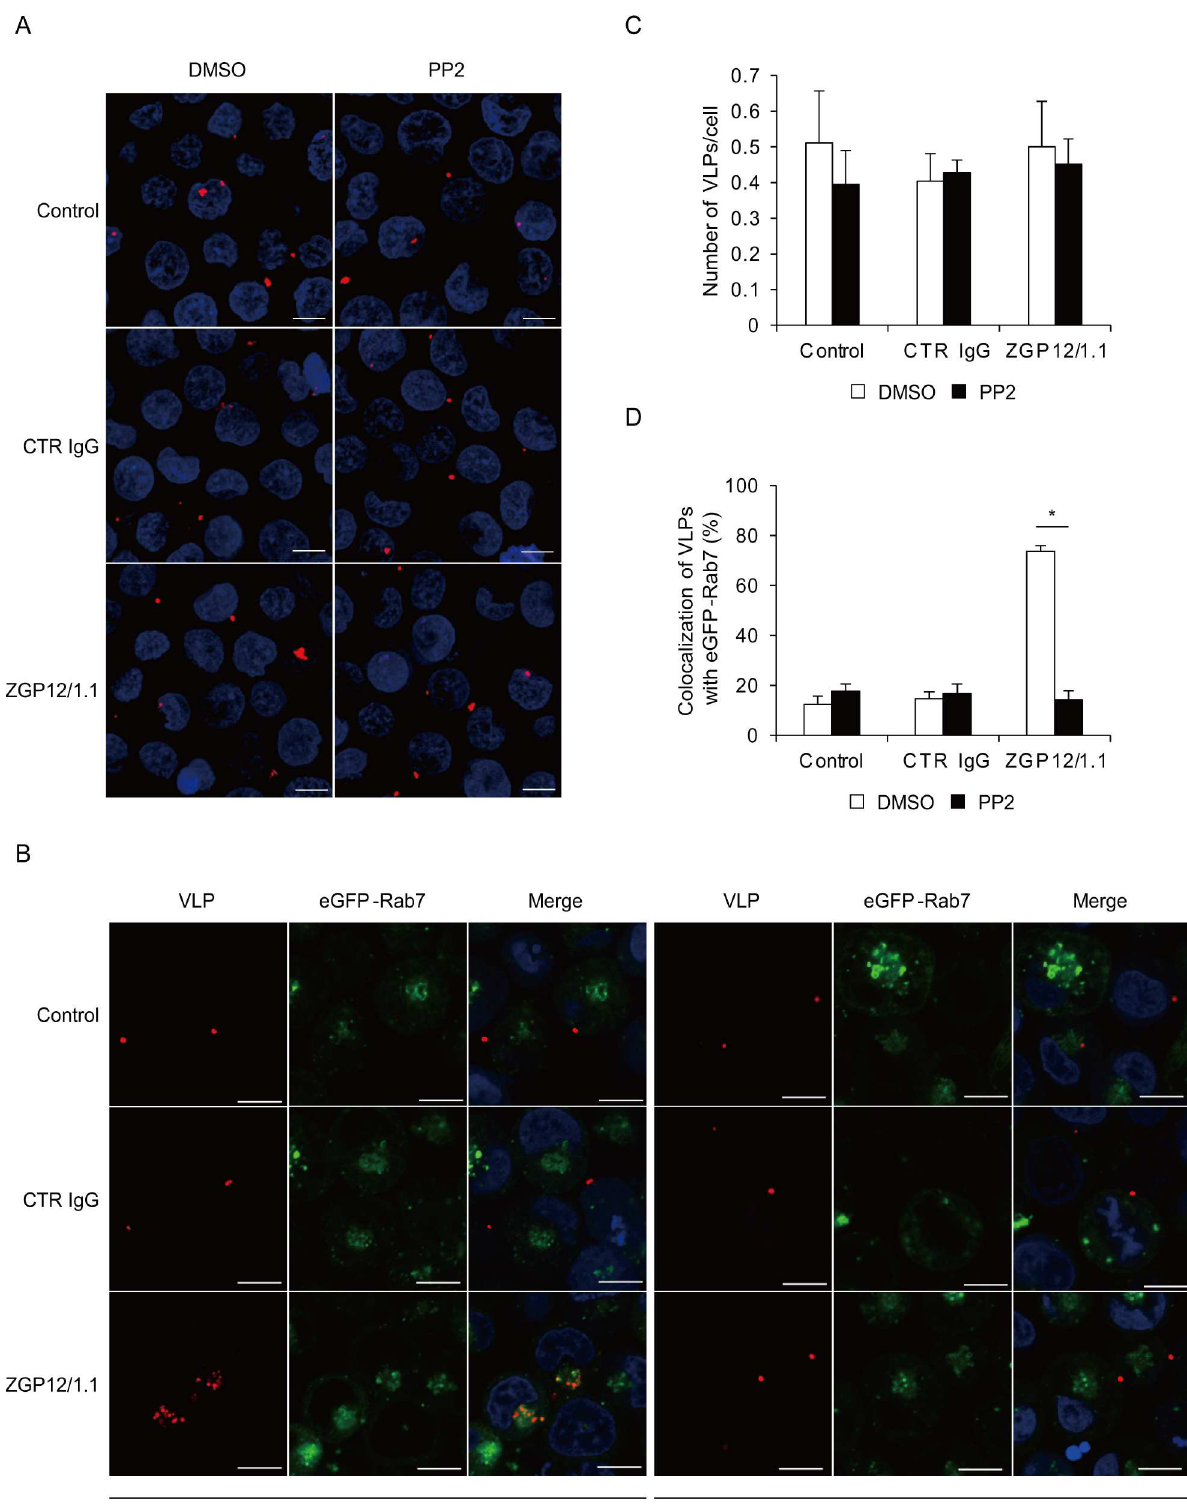
Fig 6. Enhanced VLP uptake into endosomes in K562 cells during ADE. (A, B) Fluorescent images of attachment and internalization of VLPs. (C, D) Quantifiedfluorescent signalsof VLP and Rab-7. K562 cells expressing eGFP-Rab7 were incubatedwith DMSO or